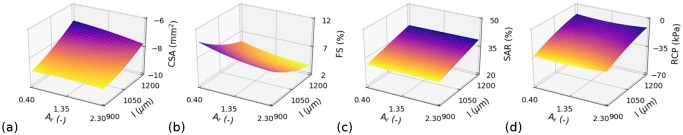
Response surfaces highlighting the combined influence of Ar and l on each performance metric (CSA, FS, SAR and RCP), holding w and t constant at their baseline values (w = 150 μm and t = 150 μm).